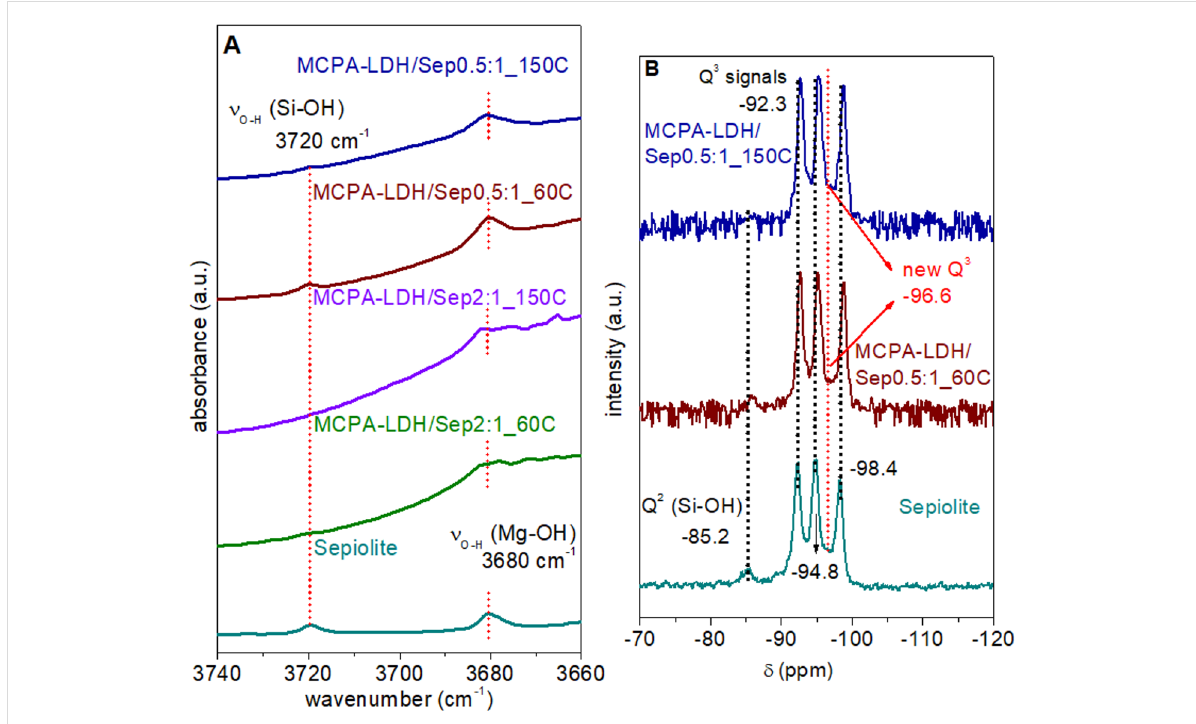
Figure 5: (A) FTIR (3800 to 3600 cm − 1 region) and (B) 29 Si MAS NMR spectra of neat sepiolite and hybrid nanoarchitectures prepared by coprecipi- tation of the MgAl-LDH in the presence of sepiolite and MCPA at different theoretical LDH/sepiolite ratios ( x :1).